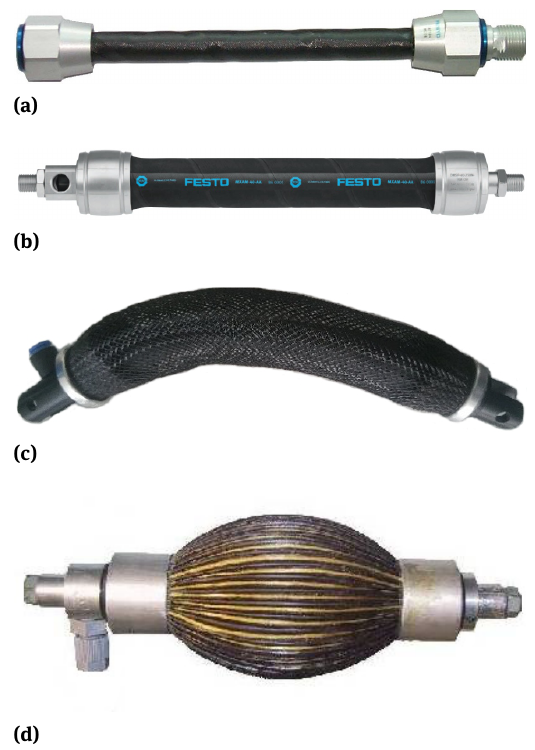
Figure 1: Pneumatic artificial muscles: a) Festo Fluidic Muscle MAS b) DMSP, c) Shadow Air Muscle SAM, d) Pleated Pneumatic Artificial Muscles PPAM.